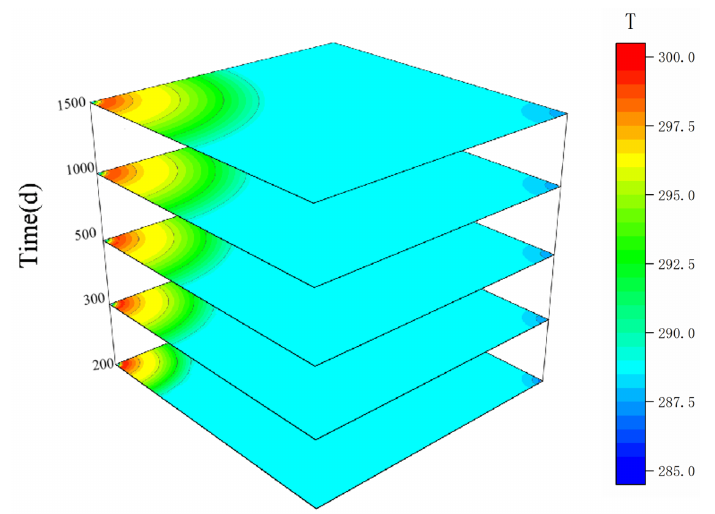
Figure 15. Reservoir temperature